Question: Compose a caption that would accompany this figure in a paper.
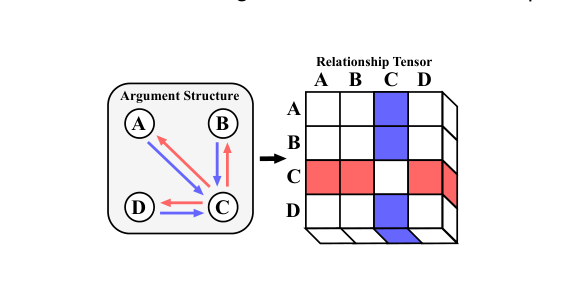
Answer: We select argument C as the observa- tion object. This example shows the correlation between the head (red) and tail (blue) relationship information and a relationship tensor. Each ele- ment in this relationship tensor is the concatenation of two arguments.